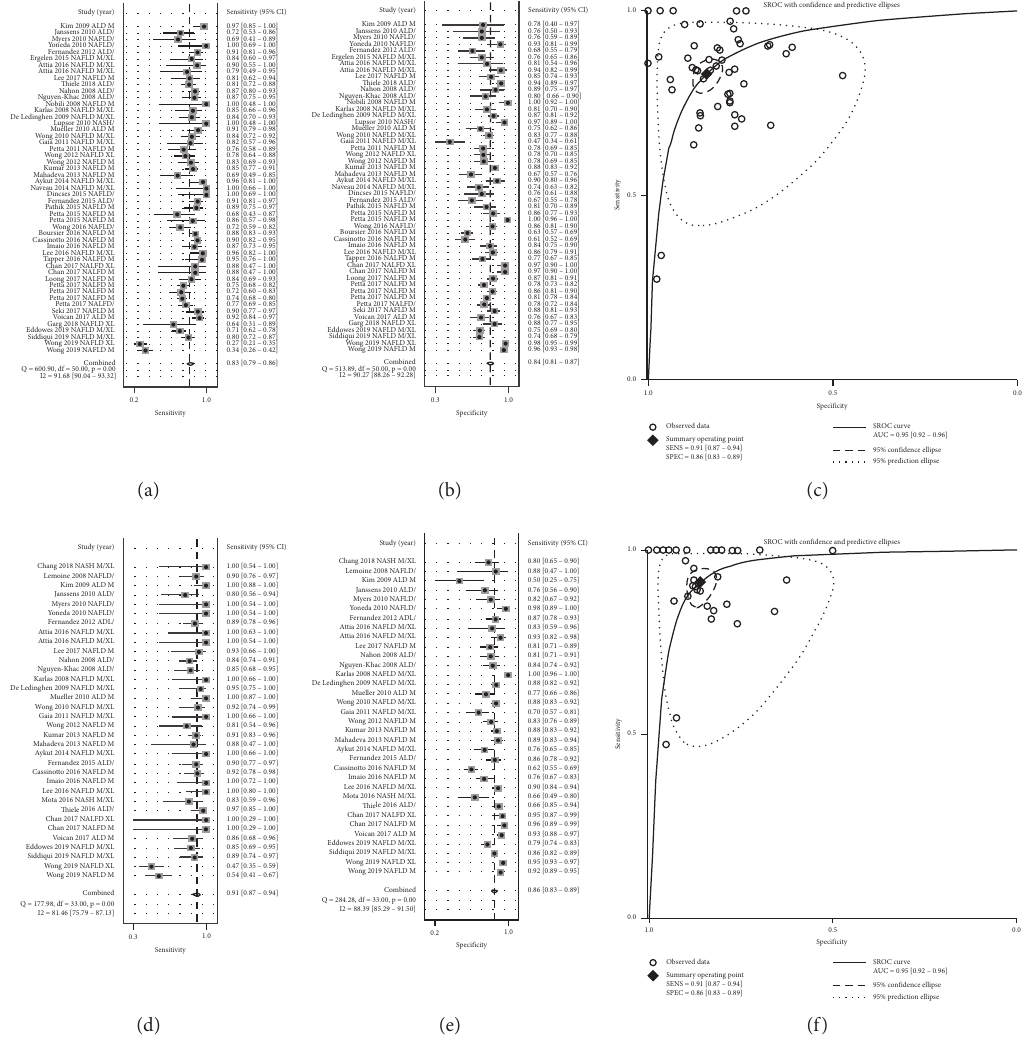
Figure 4: Diagnostic performance of liver stiffness measurement (LSM) for liver fibrosis in alcoholic liver disease/nonalcoholic fatty liver disease. (a) Sensitivity, (b) specificity, and (c) summary receiver-operating characteristics (SROC) curve of LSM for identifying patients with fibrosis grade ≥ F 3. (d) Sensitivity, (e) specificity, and (f) SROC curve of LSM for identifying patients with fibrosis grade � F 4. LSM: liver stiffness measurement; SROC: summary receiver-operating